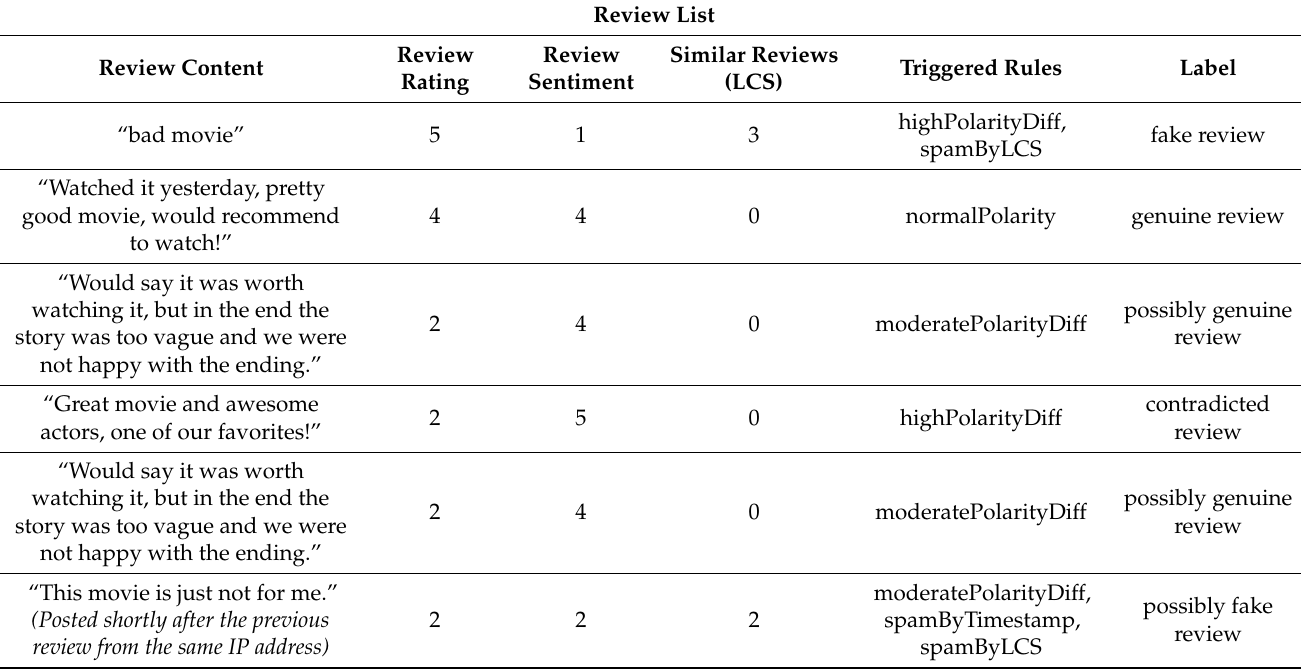
Table 1. Example reviews alongside their triggered ASP rules.